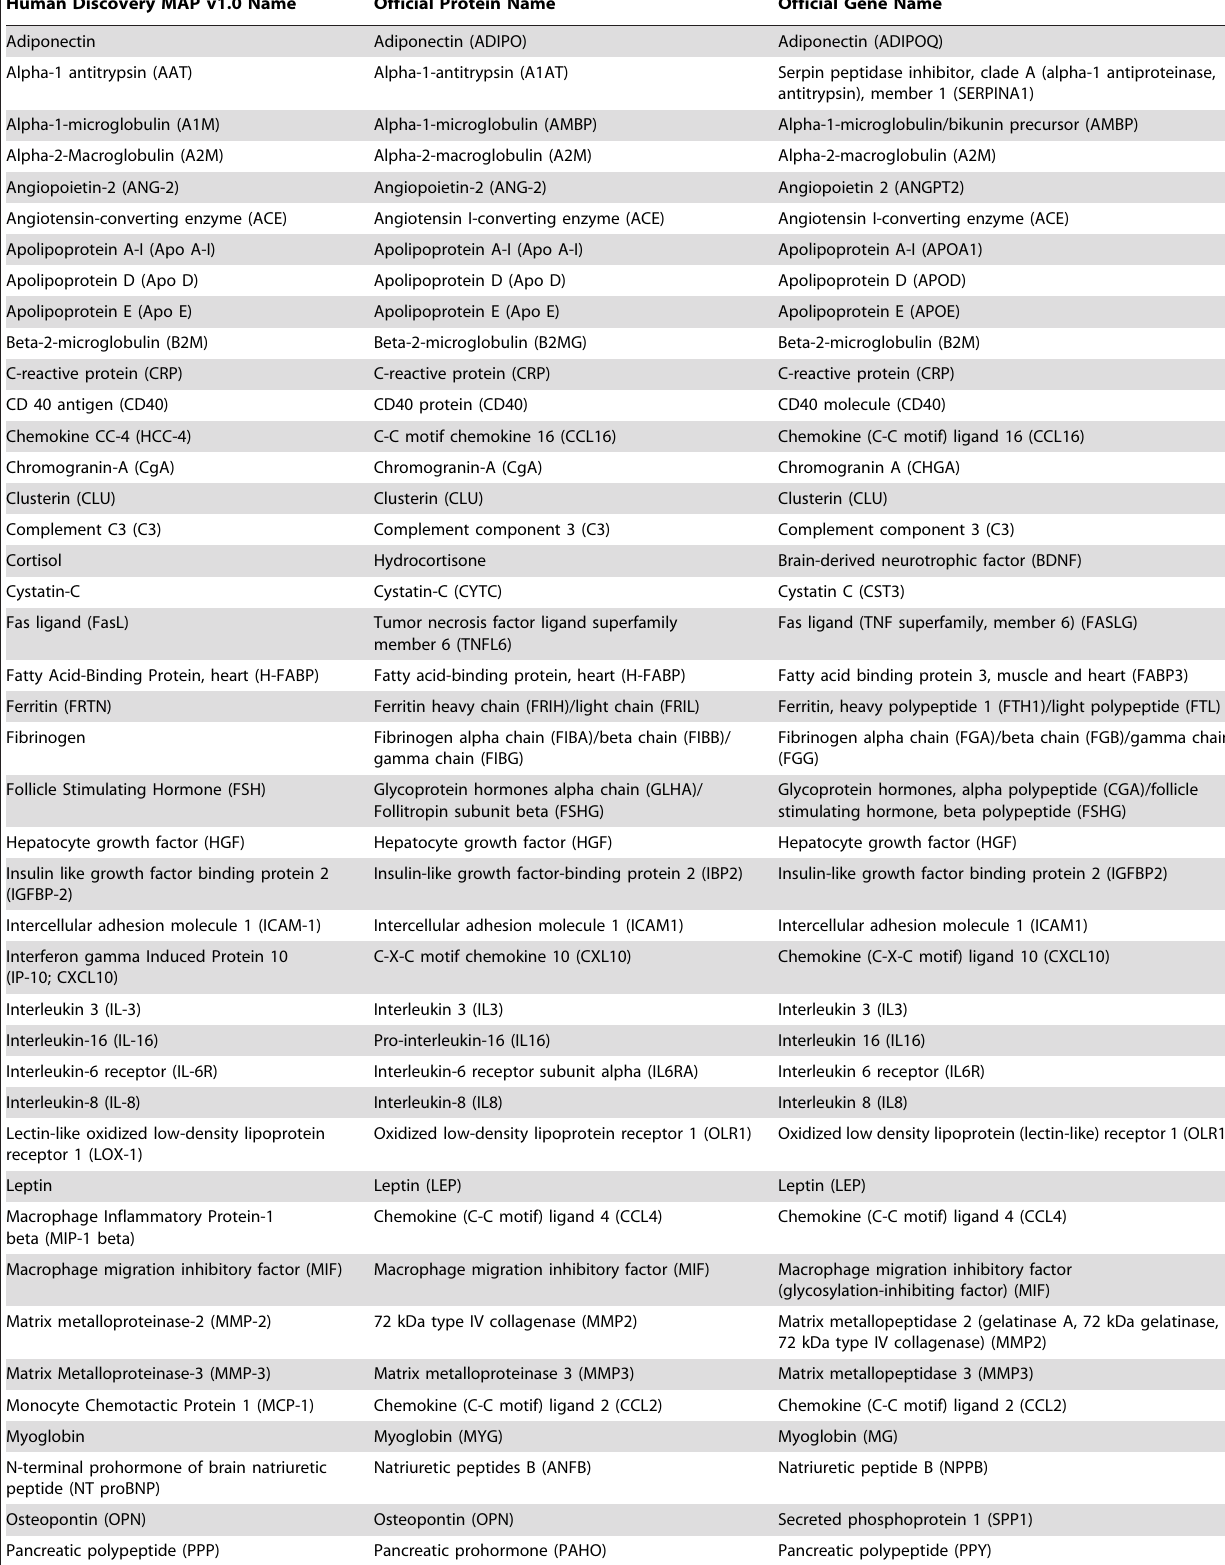
Table 1. Analyte